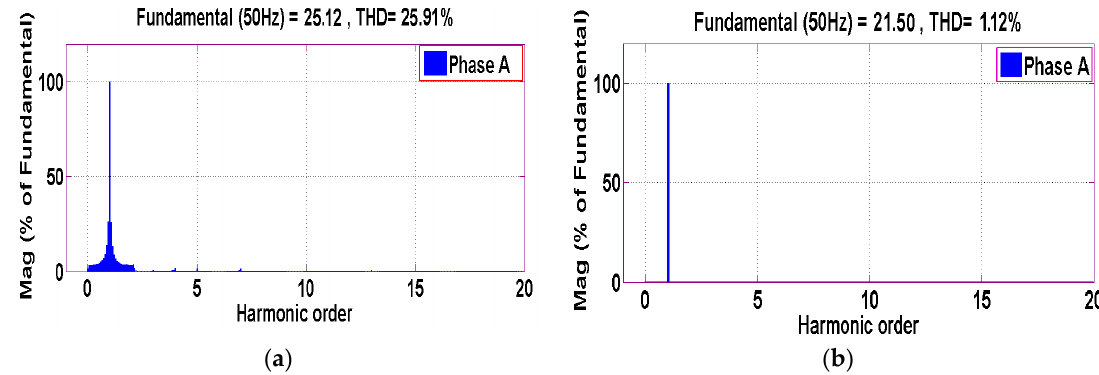
Figure 25. Simulation results under unbalanced voltages with unbalanced load: (a) THD of load current prior to compensation; (b) THD of source current after compensation.